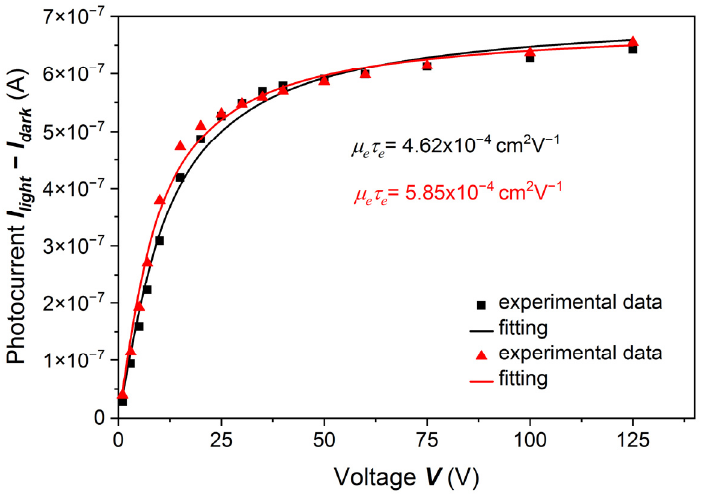
Figure 3. PC-V characteristic for two opposite surfaces (A and B) of a (Cd,Mn)Te:In sample etched with 15% HCl. Red and black symbols and curves represent results and fittings obtained for the Cd side (A) and Te side (B), respectively. The fitting was made with the Hecht equation. The standard error of μ e τ e is 0.3 × 10 − 4 cm 2 V − 1 . The contacts on both surfaces of the sample were sputtered Au/Pd layers with thicknesses ~30 nm.